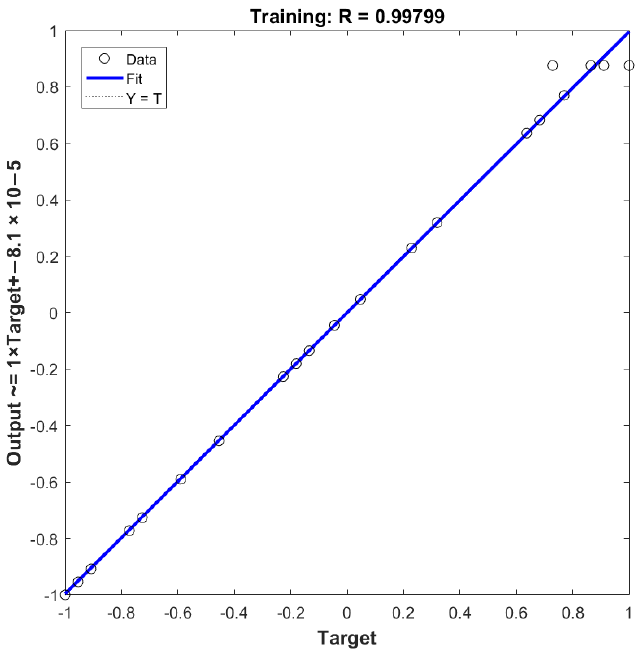
Figure 9. The experimental and predicted data of normalized decontamination. Table 4. The weights and biases of BP-ANN in input-hidden layers (w i and b i ) and hidden-output layers (w j and b j ). Number of